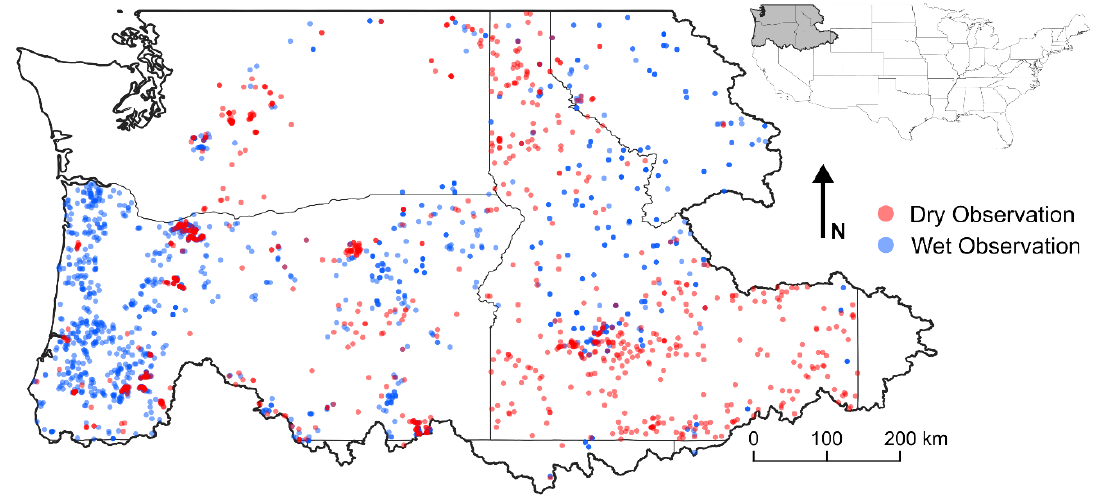
Figure 1. Location of in situ observations of surface water presence or absence on headwater streams in the Pacific Northwest from 1977 to 2019 (McShane et al., 2017).